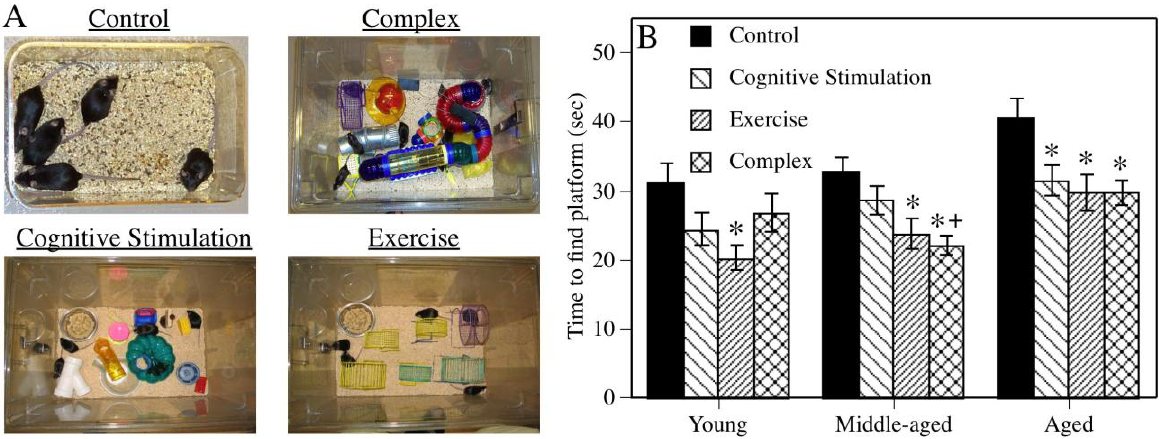
FIGURE 2 . (A) Photographs of the enrichment conditions used by Harburger et al.[71]. (B) Spatial memory in the Morris water maze as illustrated by time to find the hidden escape platform. Each bar represents the mean  SEM of five daily test sessions. * = significant difference from same-age controls, + = significant difference from same-age cognitive stimulation group. Figure modified from Harburger et